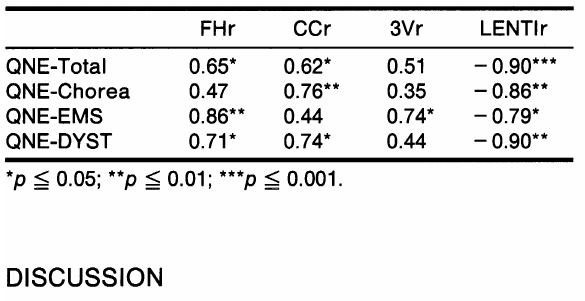
TABLE Vb. Correlations between ONE movement impair ment indices and neuroanatomical atrophy in "late" HO (n =